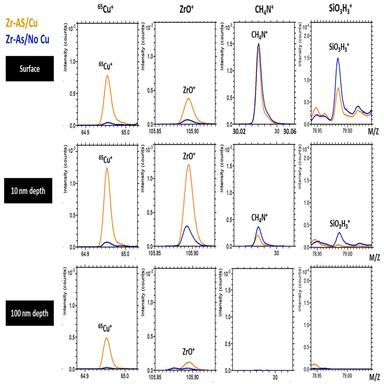
The comparison of the ToF-SIMS depth profile for different fragments at different depths.